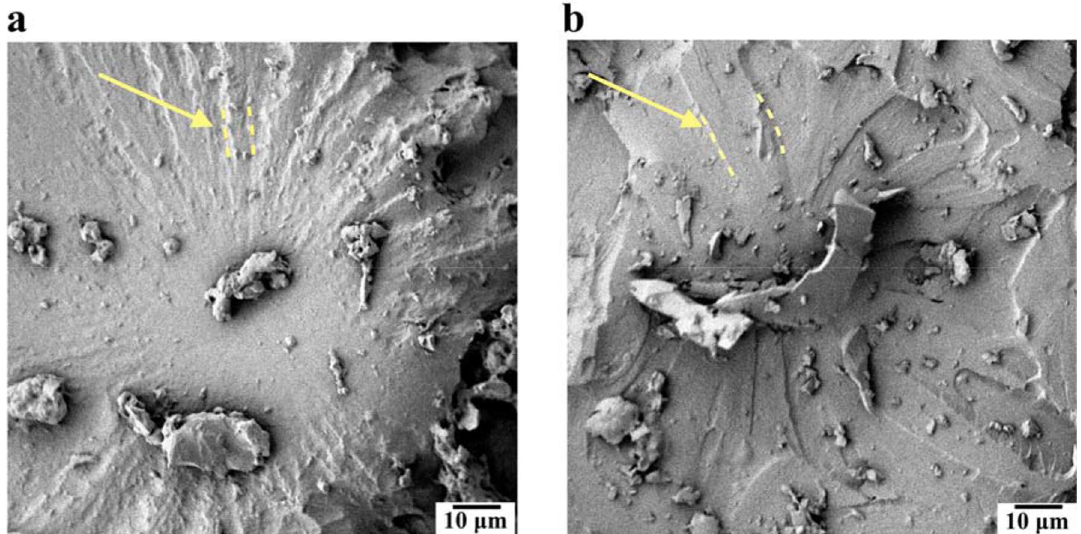
Figure 4. FESEM images of spherulitic texture in the (a) neat PU and (b) nanocomposite spalled surfaces with the discernible difference of thickness between lamellar crystal bundles indicated by dashed lines and arrows.